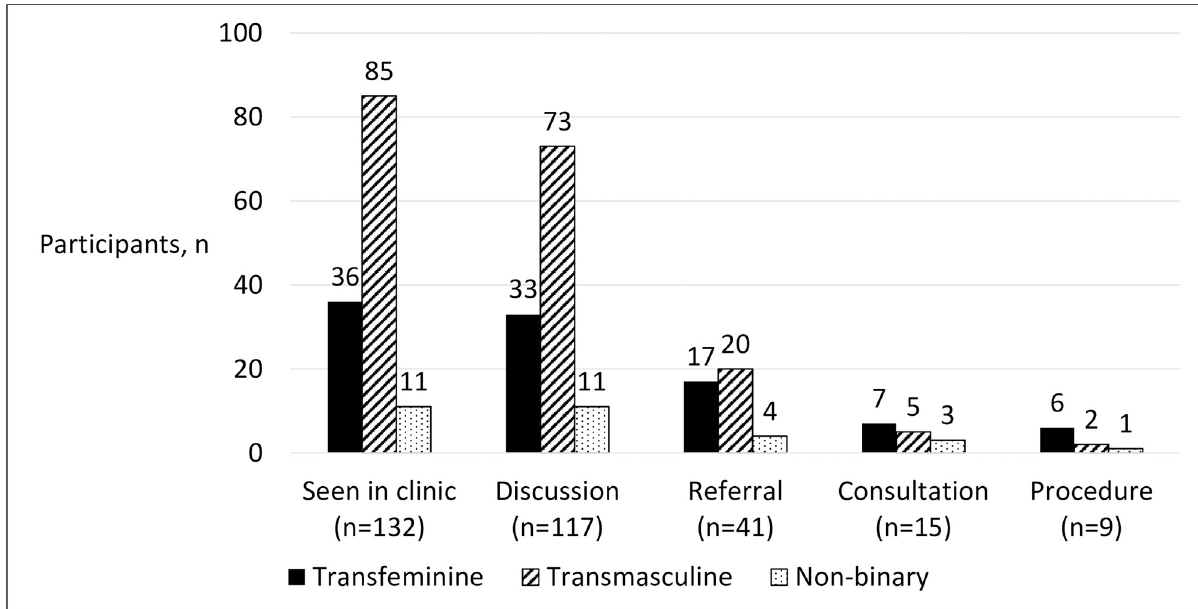
Fig 3. Fertility preservation consultation and utilization by gender identity. Patients are classified as “Seen in clinic” if they met inclusion criteria. Those that have documented discussion of fertility preservation are included in “Discussion” and those who accepted referral in “Referral.” If patients were seen in formal consultation for fertility preservation or underwent a fertility preservation procedure, they are included in “Consultation” and “Procedure,” respectively. Transfeminine patients are assigned male at birth but identify as female while transmasculine patients are assigned female at birth but identify as male. Non-binary patients do not identify as exclusively male or female and may have been assigned either male or female at birth. Numbers above bars indicate counts (n) within each category with a total of 132 patients.